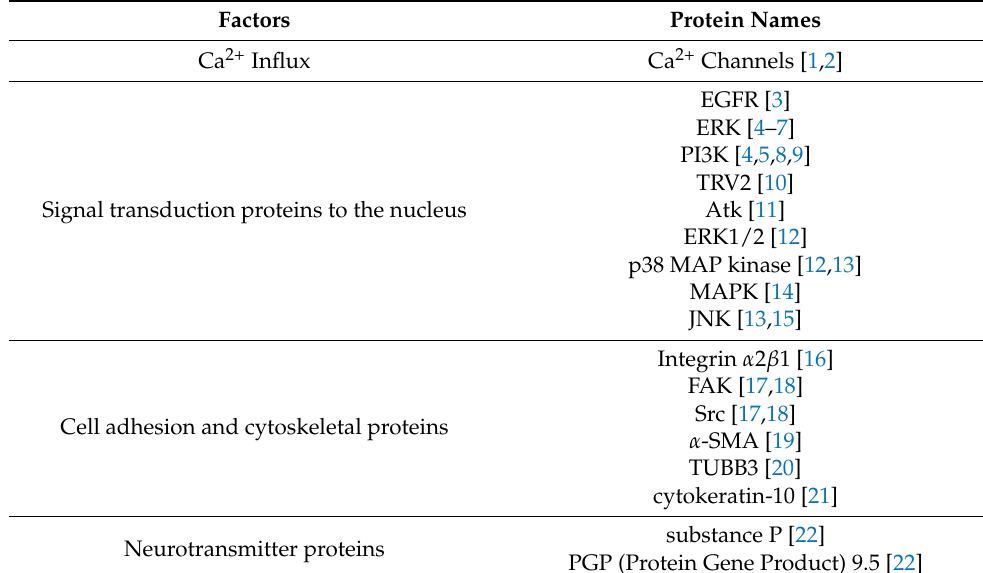
Table 1. List of signal transduction proteins influenced by electrical stimulation appearing in this